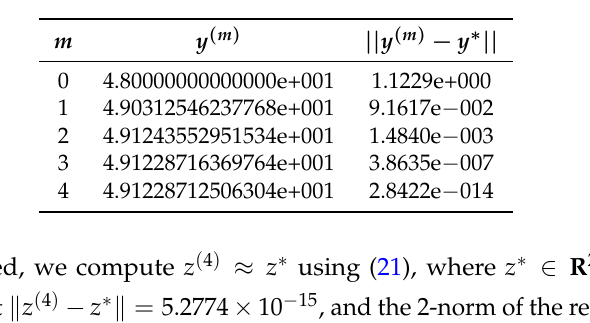
Table 1. Gauss–Newton type iterations for Example